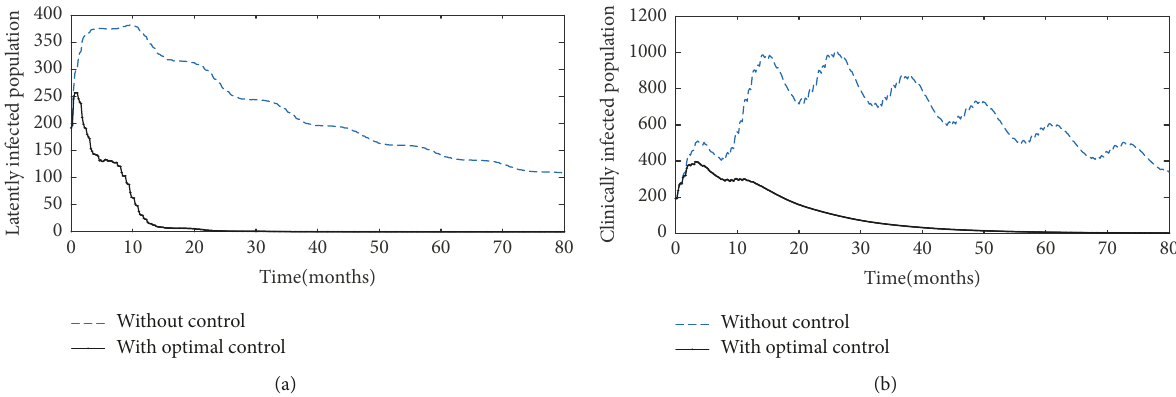
Figure 4: The numbers of exposed and infectious human population with and without the optimal control.